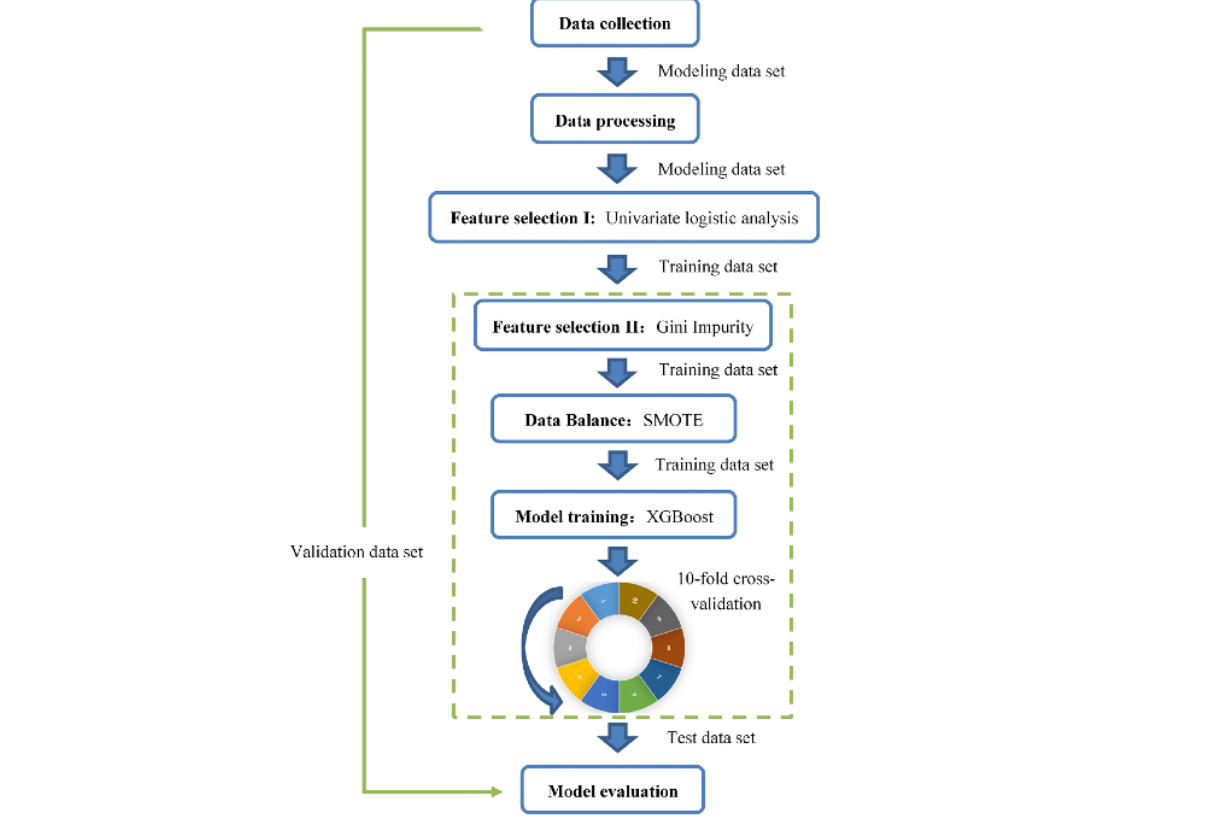
Figure 2. Procedure flow of modeling. SMOTE: Synthetic Minority Oversampling Technique; XGBoost: extreme Gradient